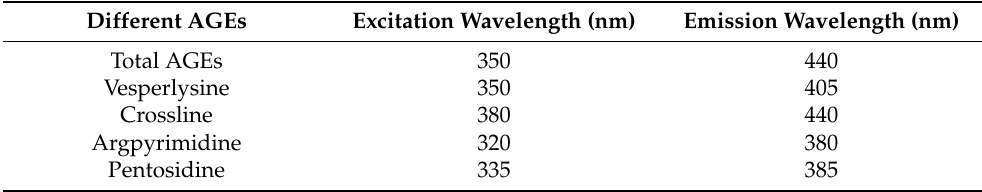
Table 3. The excitation and emission wavelength of different fluorescent